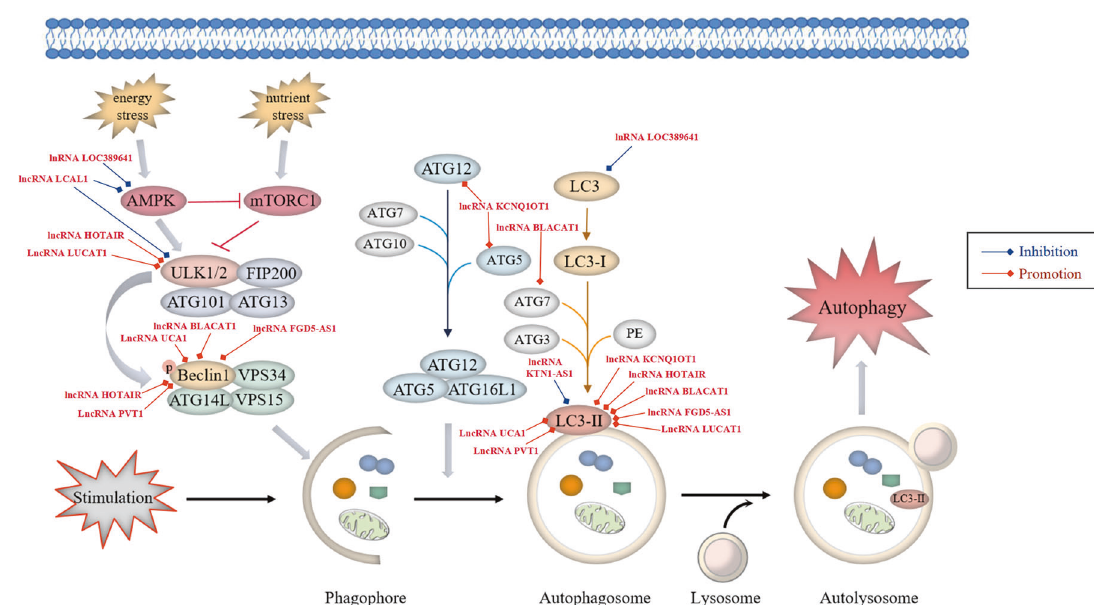
Fig. 3 LncRNAs regulate the autophagy pathways in NSCLC. Autophagy starts with the formation of phagophores. The formation of unc-51- like kinase (ULK) complex from ULK1/2 kinase, ATG13, ATG101 and family-interacting protein FIP200, directly modulated by integrated signals from the mechanistic target of rapamycin complex 1 (mTORC1) and AMP-activated protein kinase (AMPK) signalling, triggers autophagic activity. Activated ULK1 can lead to the phosphorylation of Beclin1, thus activating class III PI3-kinase (VPS34) complex, which consists of VPS34, Beclin-1, VPS15 and ATG14L, primarily responsible for the nucleation of autophagosomal membrane. Two principal ubiquitination systems, ATG5-ATG12 and LC3 conjugation systems participate in autophagophore elongation and conversion into intact autophagosome. Respectively, ATG5 and ATG12 assemble into a complex, which then interacts with ATG16L1 to form a multimeric ATG12-ATG5-ATG16L1 conjugate that is on the outer surface of the autophagosomal membrane. Membrane-bound LC3-II is generated by the conjugation of microtubule-associated protein 1-light chain 3-I (LC3-I) to the lipid phosphatidylethanolamine (PE), providing a docking site for mounting autophagy cargo receptors that enable cargo loading into the autophagic vesicles. Various oncogenic lncRNAs (red font, high expression in NSCLC) participate in lung cancer-associated autophagy by regulating autophagy-related